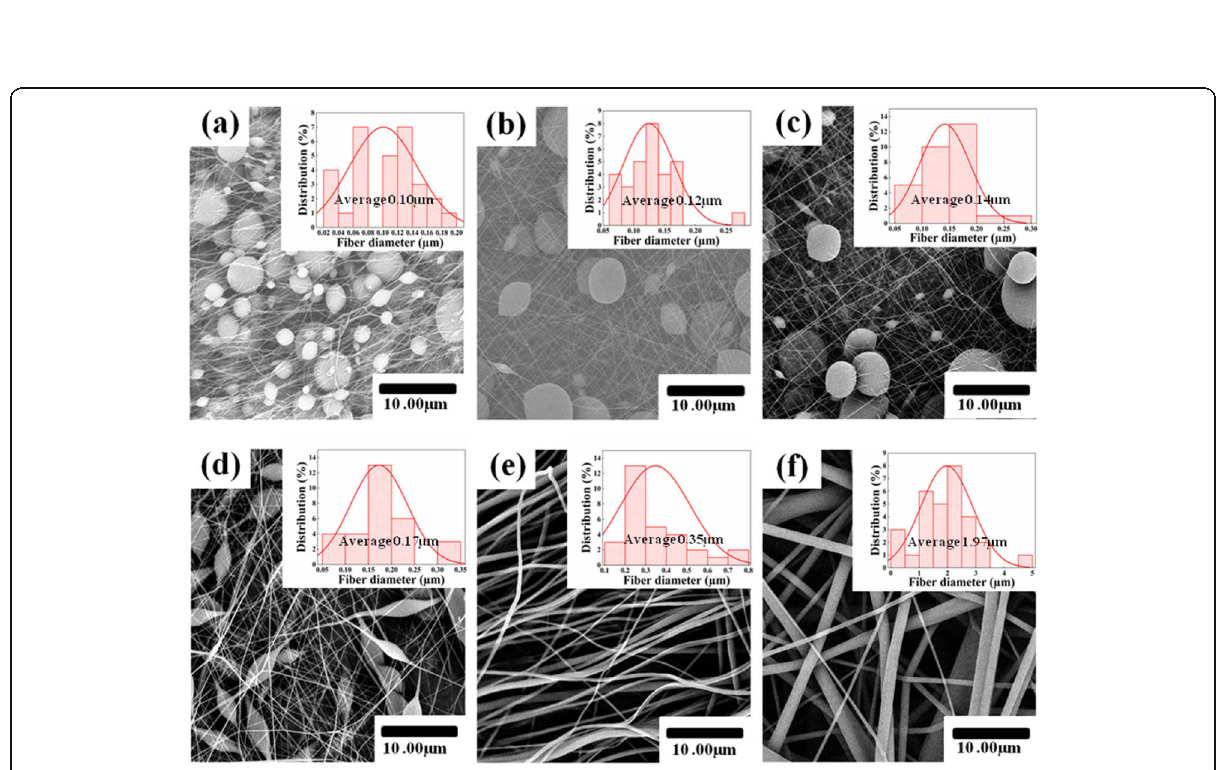
Fig. 2 SEM images of electrospun TPU. a – f SEM images and diameter distributions with TPU concentrations of 6 wt%, 8 wt%, 10 wt%, 12 wt%, 14 wt%, and 16 wt%,